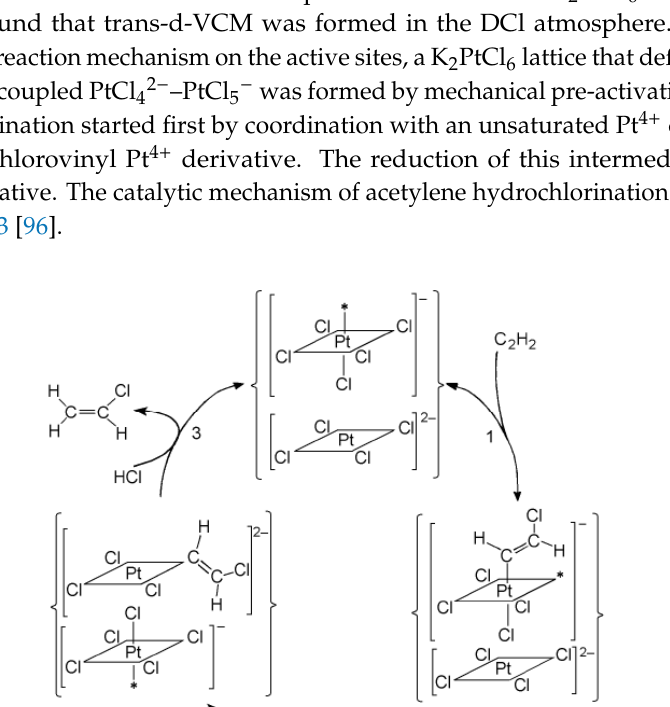
Table 4. Performance of Pd catalysts for acetylene hydrochlorination.